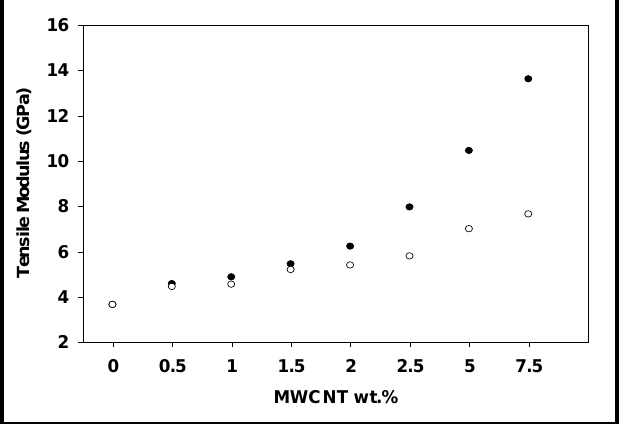
) and Ar-CNT-C ( ) composites. (cid:35)